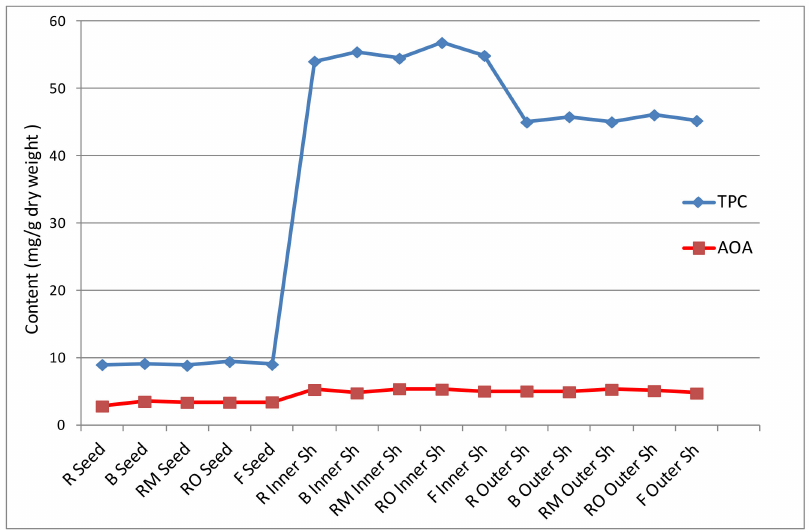
Figure 2. Total phenolic content (TPC) and antioxidant activity (AOA) of seeds and inner and outer shells of chestnut (TPC = mg GAE/g dry weight; AOA = mg Trolox equivalent (TE)/g dry weight). R (raw); B (boiled); RM (roasted, microwave); RO (roasted, oven); F (fried); sh (shell).